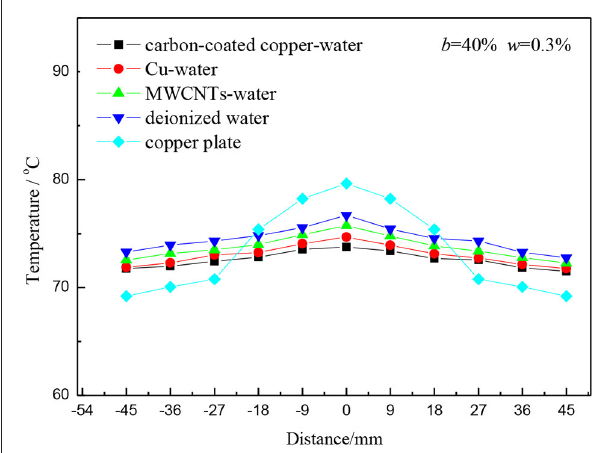
FIGURE 4 | Surface temperature distributions of different medium